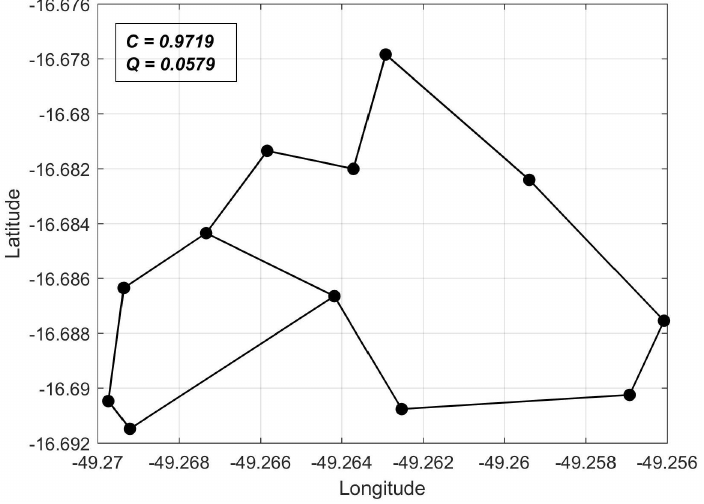
Figure 5. Solution S 3 with low cost in Q - C